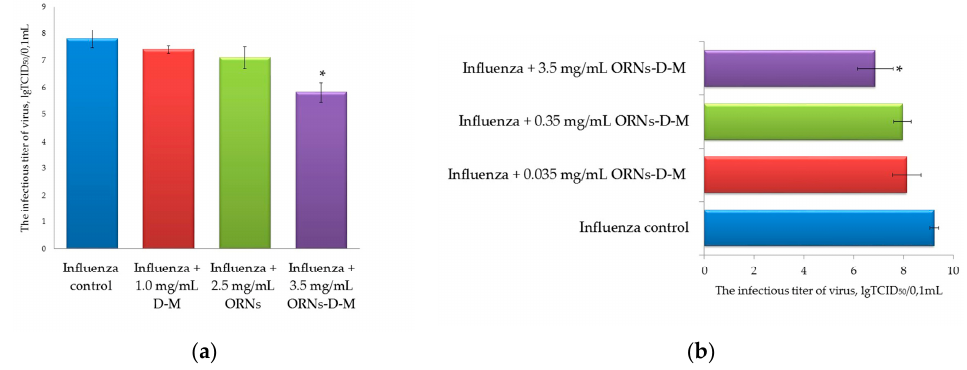
Figure 2. ( a ) Decrease of the influenza A virus H1N1 (A/FM/1/47) infectious titer after incubation with the ORNs- D -M; ( b ) Effects of different concentrations of the ORNs- D -M on infectious titer of the influenza A virus H1N1 (A/FM/1/47). Influenza control: virus without drug preincubation, Influenza + D-M: virus preincubated with 1.0 mg/mL of the D-M; Influenza + ORNs: virus preincubated